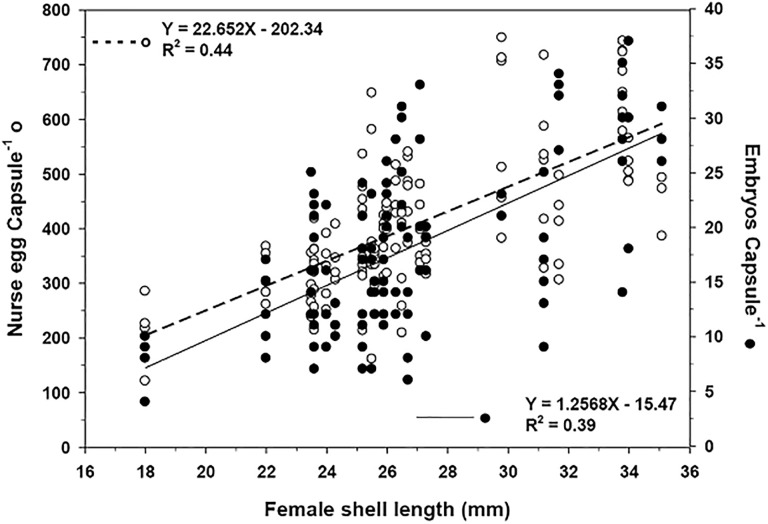
Crepipatella dilatata.Shell length of the brooding female and the characteristics of capsule contents: embryos per capsule (straight line, N = 116) and nurse eggs (dashed line, N = 125) per capsule. In the figure, only information obtained during July 2004 was used in consideration of the specific level of development of the embryos.